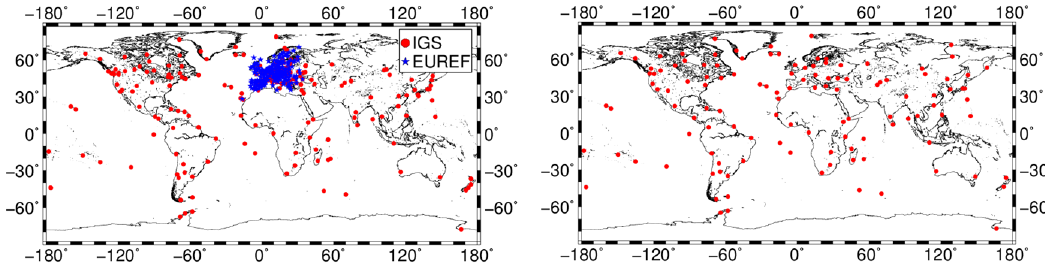
Figure 3. Receiver stations of the global IGS network (red dots) and the European EUREF network (blue dots), left panel ; selected receiver stations which provide observations for the global data set D 1 , right panel .